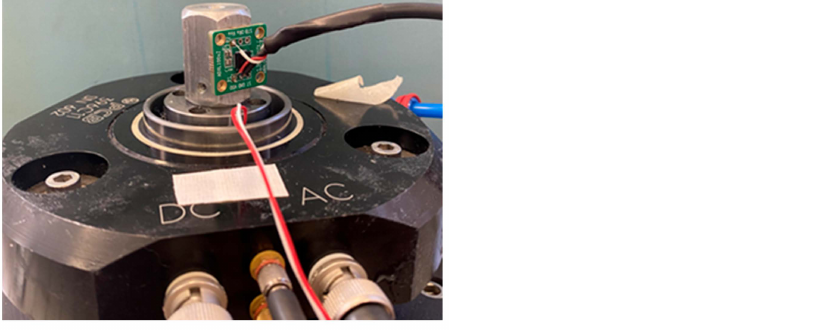
Figure 5. The individual sensing element ADXL 1005Z on the vertical instrumented vibration table.